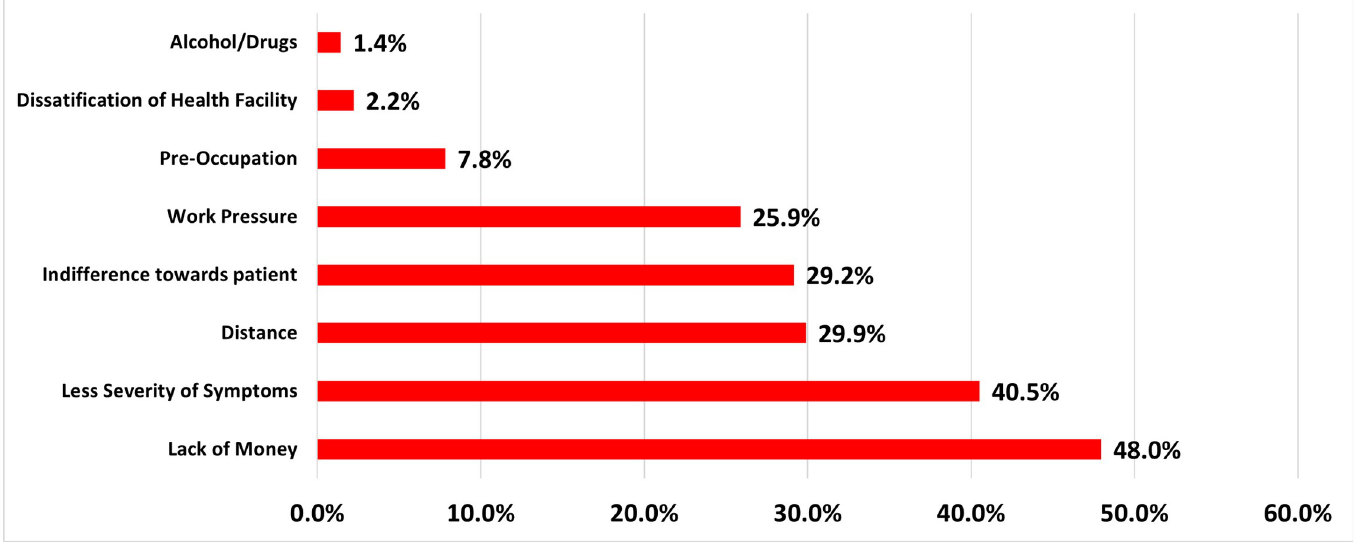
Fig 2. Reasons for not seeking